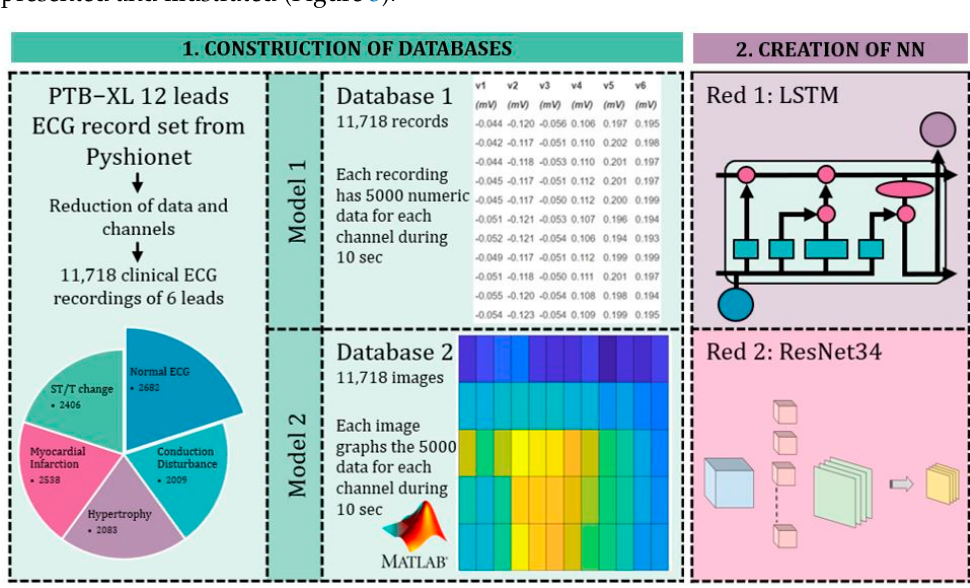
Figure 3. Block diagram of the research: the signal processing and construction of the models.